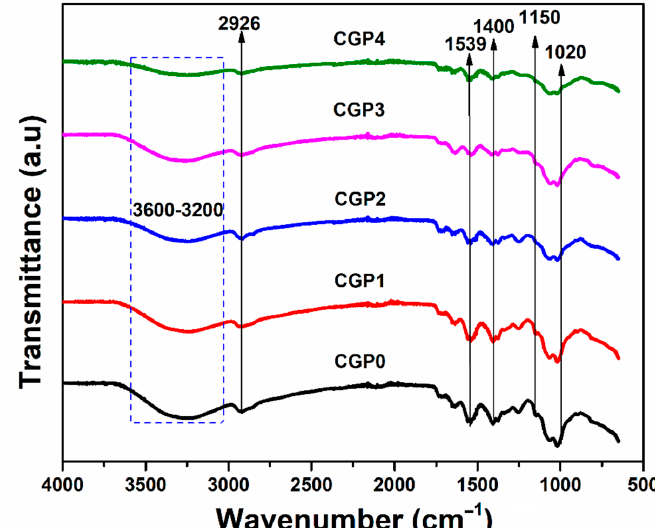
Figure 1 . FTIR spectrum of prepared hydrogels . Figure 1. FTIR spectrum of prepared hydrogels.